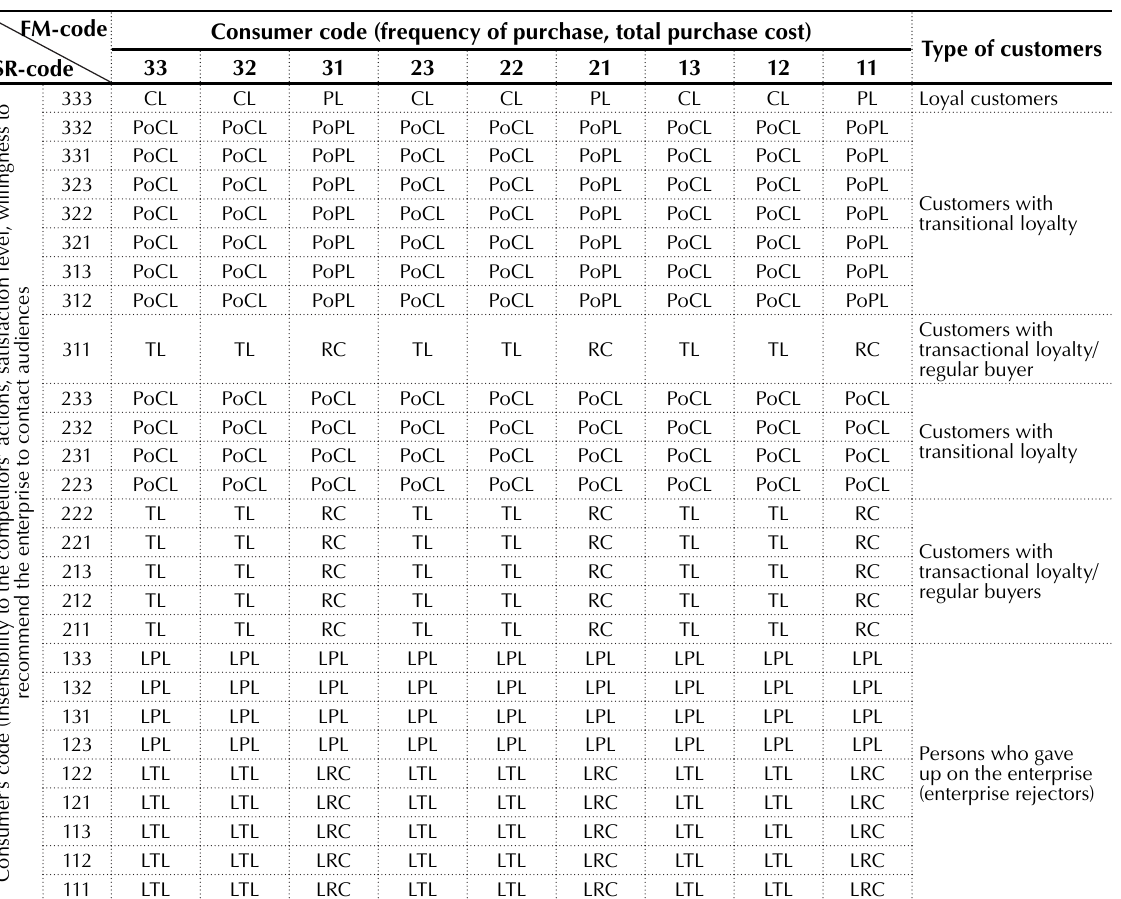
Table 4. Segments of